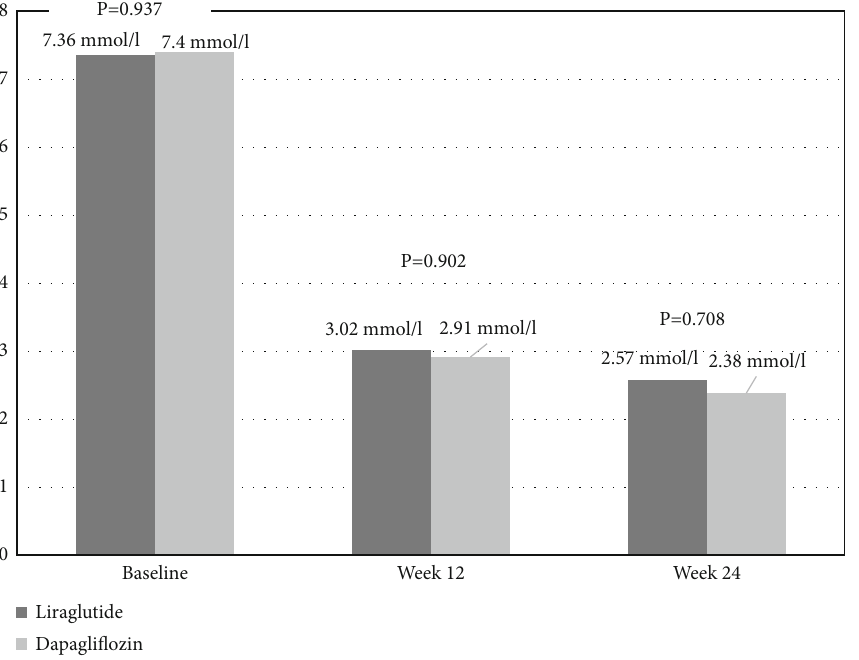
Figure 2: Comparison of PPGE between the two groups at week 12 and week 24. Abbreviations: PPGE: 2-hour incremental postprandial glucose